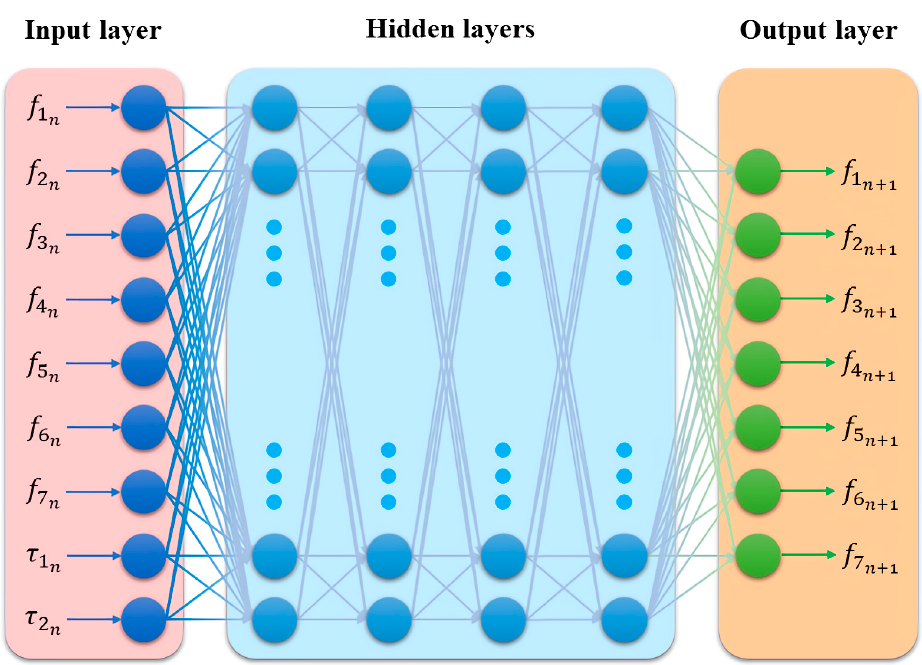
Figure 5. Neural networks of the neural feedback controller, which aim to generate the tensile forces for each skeletal muscle based on the torques needed for arm reaching movements.